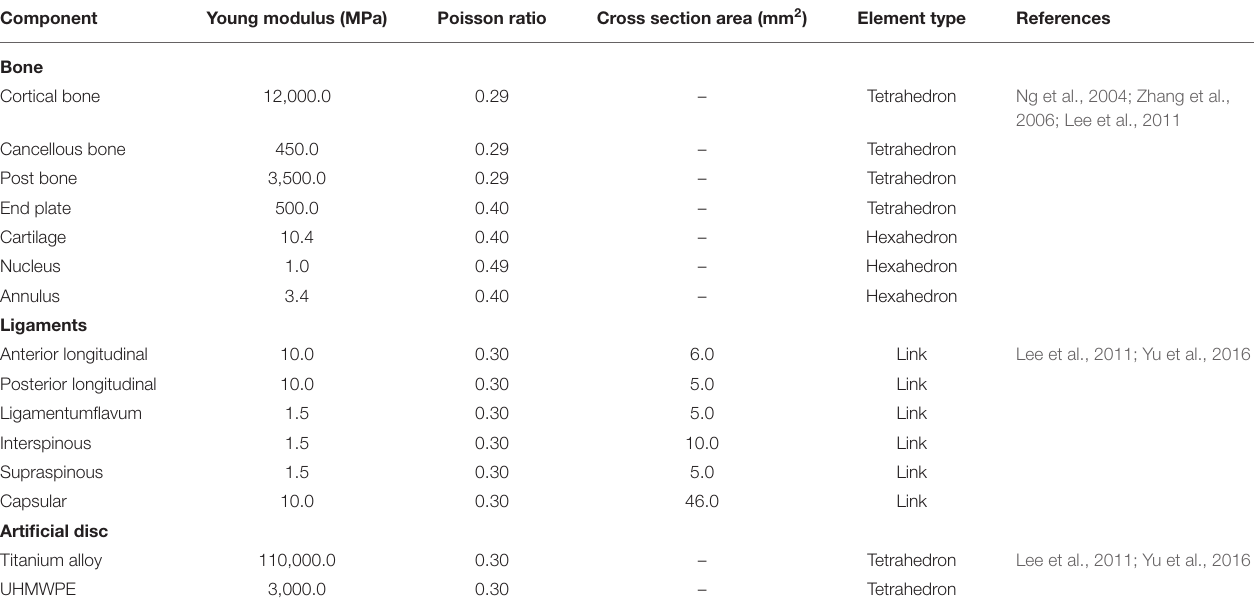
TABLE 1 | Material property and mesh type of the prostheses and cervical spine components. Component